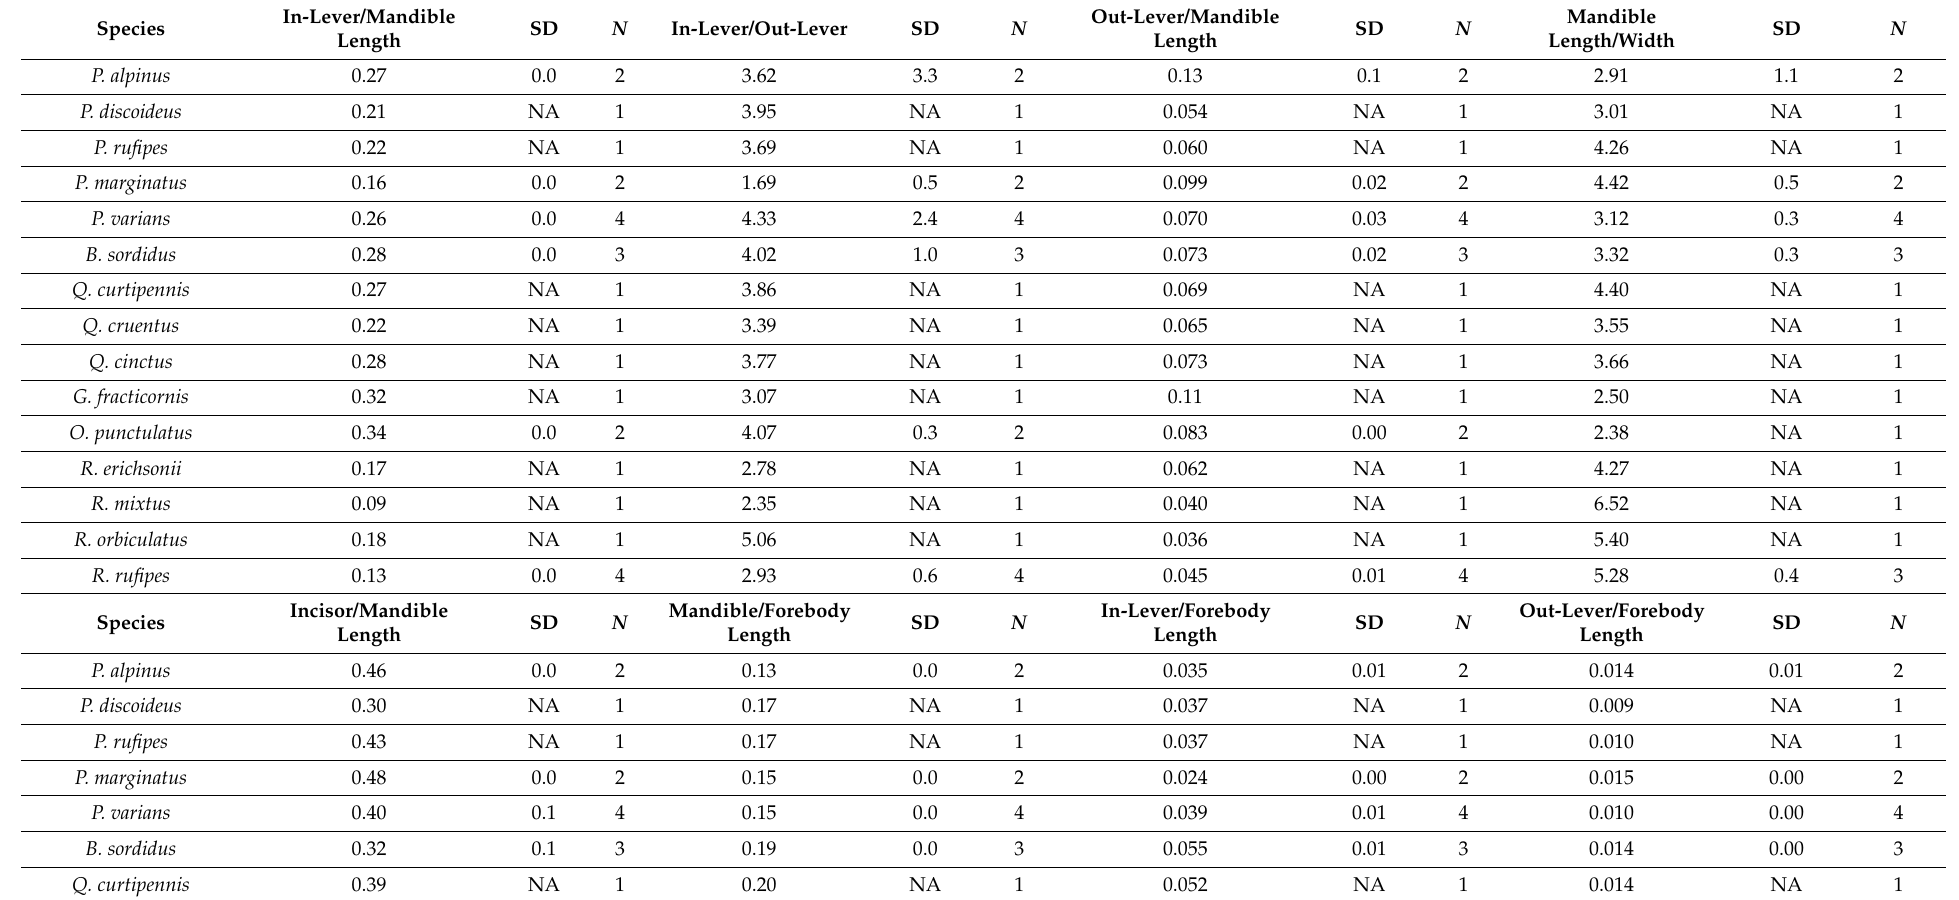
Table A1. Table of arithmetic means obtained for morphological ratios and prey-capture ratios for each species with sample size N and standard deviation (SD). NA: calculation not possible because of small sample